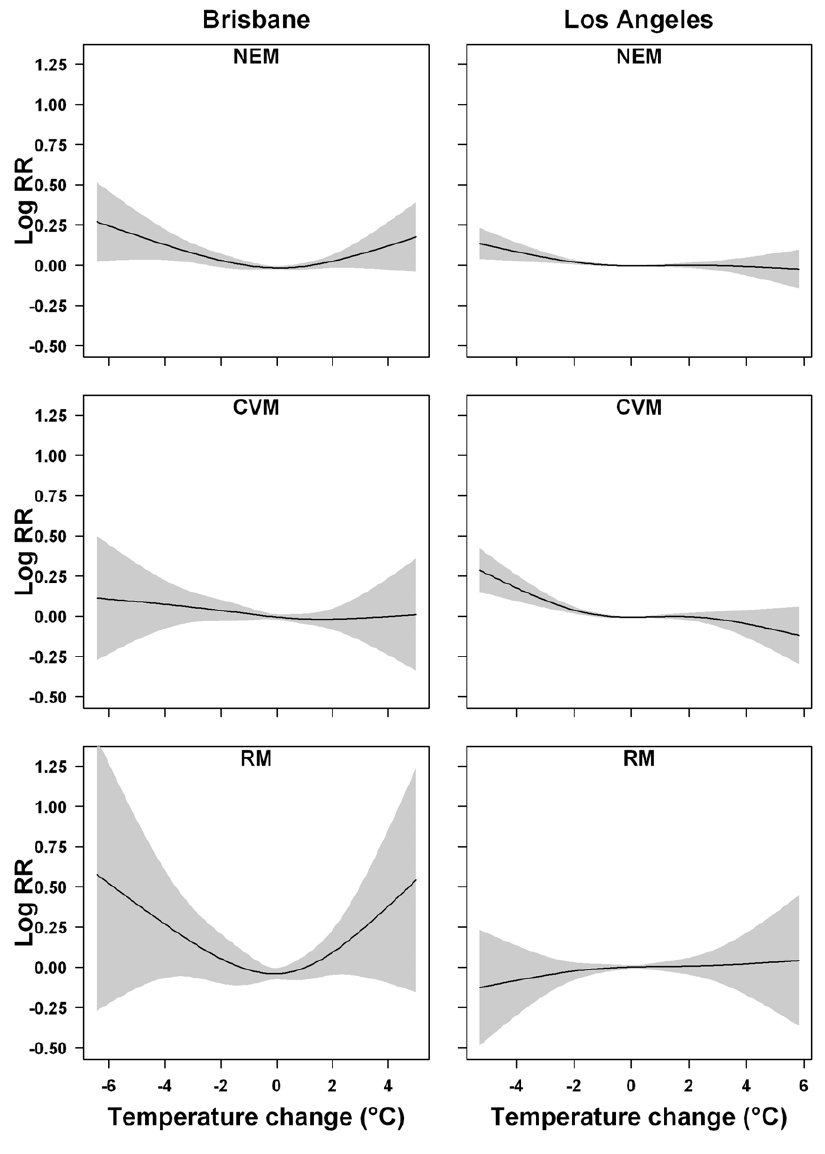
Figure 1. The associations between temperature change and non-external mortality, cardiovascular mortality, and respiratory mortality using model (1) in Brisbane, Australia (left side) and Los Angeles, United States (right side).